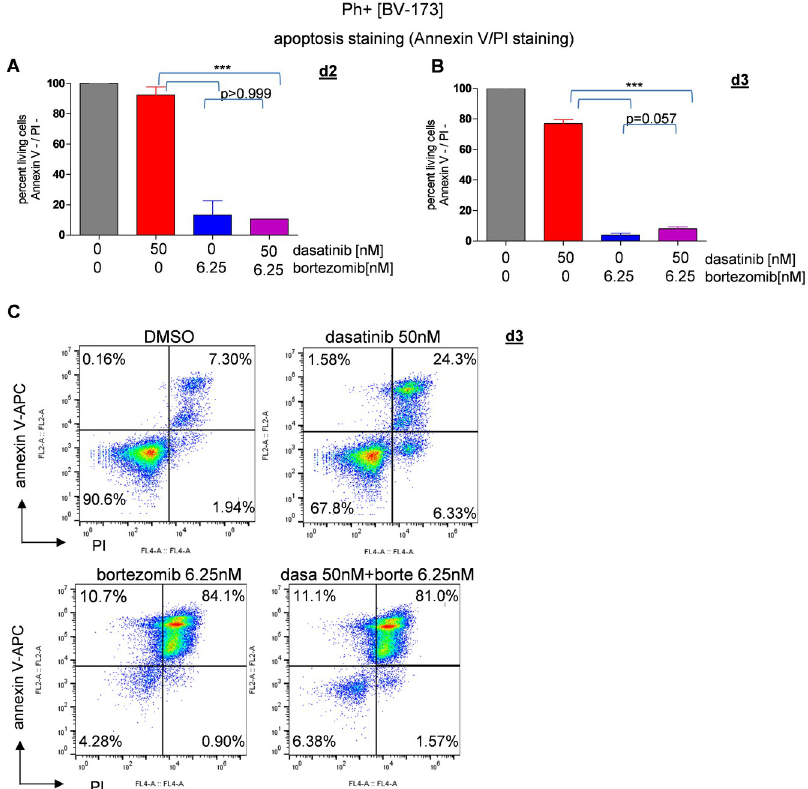
Fig 2. Apoptosis induction by combination of bortezomib and dasatinib in BV-173 measured via annexin V / PI staining. (A+B) Ph+ cells BV-173 treated with DMSO, dasatinib 50nM, bortezomib 6.25nM. Apoptosis assay was separately performed at day 2 and day 3 for both cell lines, only d3 is shown in the graphics. Bortezomib as well as combination treatment leads to apoptosis. At day 3 only 8.1 ± 1.22% of the combinated treated cells were non apoptotic (Annexin V-/PI-). We detected no significant difference between bortezomib only and dasatinib + bortezomib treatment (p > 0.999 at day 2 and p = 0.057 at day 3). Even though only two sets of experiments have been performed, we argue that a third pass would not have changed the set of results. The reader should please be aware of the n = 2 here. (C) With the combination treatment of dasatinib and bortezomib, 81.0% of BV-173 cells are found in late apoptosis at day 3 (annexin V+/PI+). For all analyses, p values were calculated by one-way ANOVA with Bonferroni multiple comparison test. A p value of less than 0.05 was considered statistically significant for all analyses. ( � ,p < 0.05, �� ,p < 0.01, ��� ,p < 0.001), error bars = SD, n = 2/2). Recovery of ixazomib-treated cells results in a time-dependent synergism with TKI